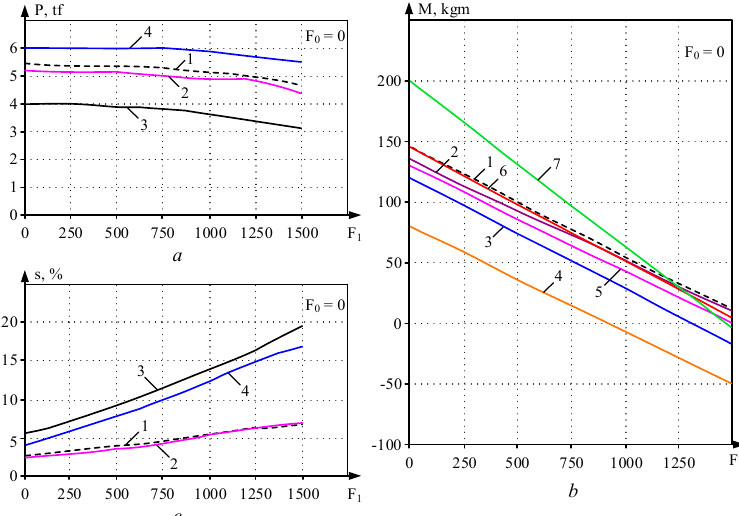
Figure 9. Calculated and experimental dependences of pressure ( a ), torque ( b ) and flow ( c ) from the front tension. Machines 2020 , 8 , x FOR PEER REVIEW